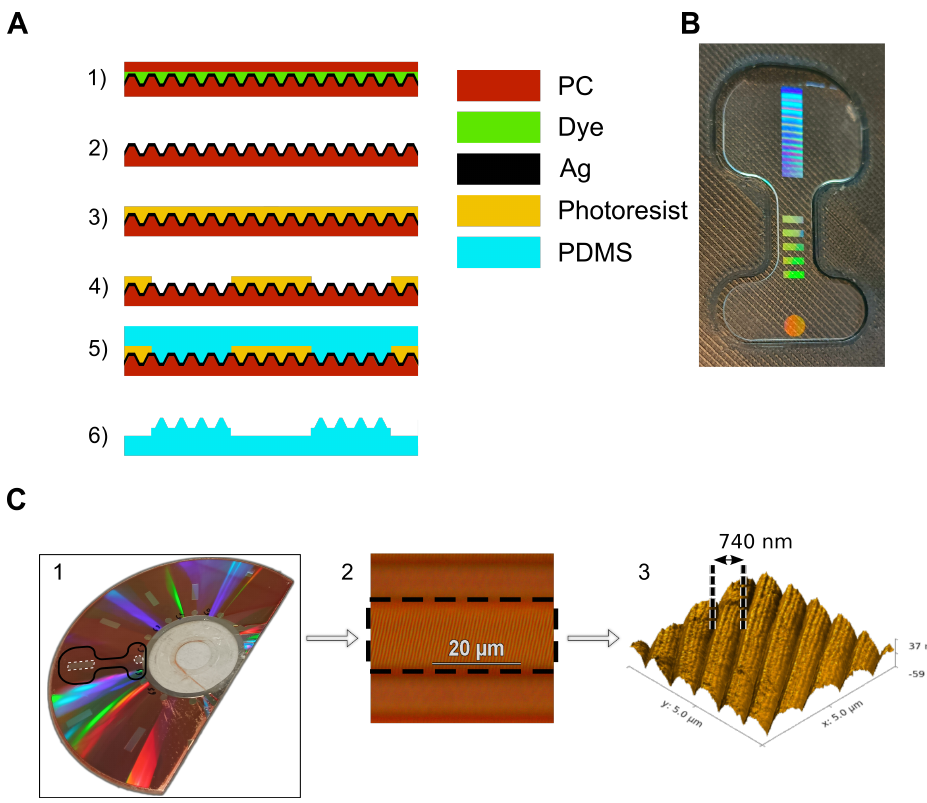
Figure 2. ( A ) Schematic diagram of the manufacturing process for the waveguide mould with MEMS surface micro-machining technologies; (1) DVD-R structure; (2) Separation of the top PC layer and removal of dye; (3) Spin coating of photoresist; (4) Patterning photoresist; (5) Spin coating of PDMS; (6) CO 2 laser cutting and peel-off to reveal the final structure. ( B ) Photographic image of a stretchable planar waveguide (dog bone form) under white light illumination. ( C ) Three images of a patterned DVD-R substrate ready for waveguide fabrication. (1) Photograph of the prepared mould DVD-R with photoresist lines. The shape of a single device, to be cut by CO 2 laser is shown in black, and the exposed grating zones are highlights with dashed white. (2) Optical microscope image of a single grating zone. The areas, top and bottom, covered with photoresist are smooth; the area in the centre, highlighted with a dashed black box, is exposed and shows the underlying DVD-R grating structure. (3) AFM image of a section of exposed DVD-R grating after removal of photoresist to define the waveguide diffraction grating. The characteristic grating distance of 740 nm is shown.